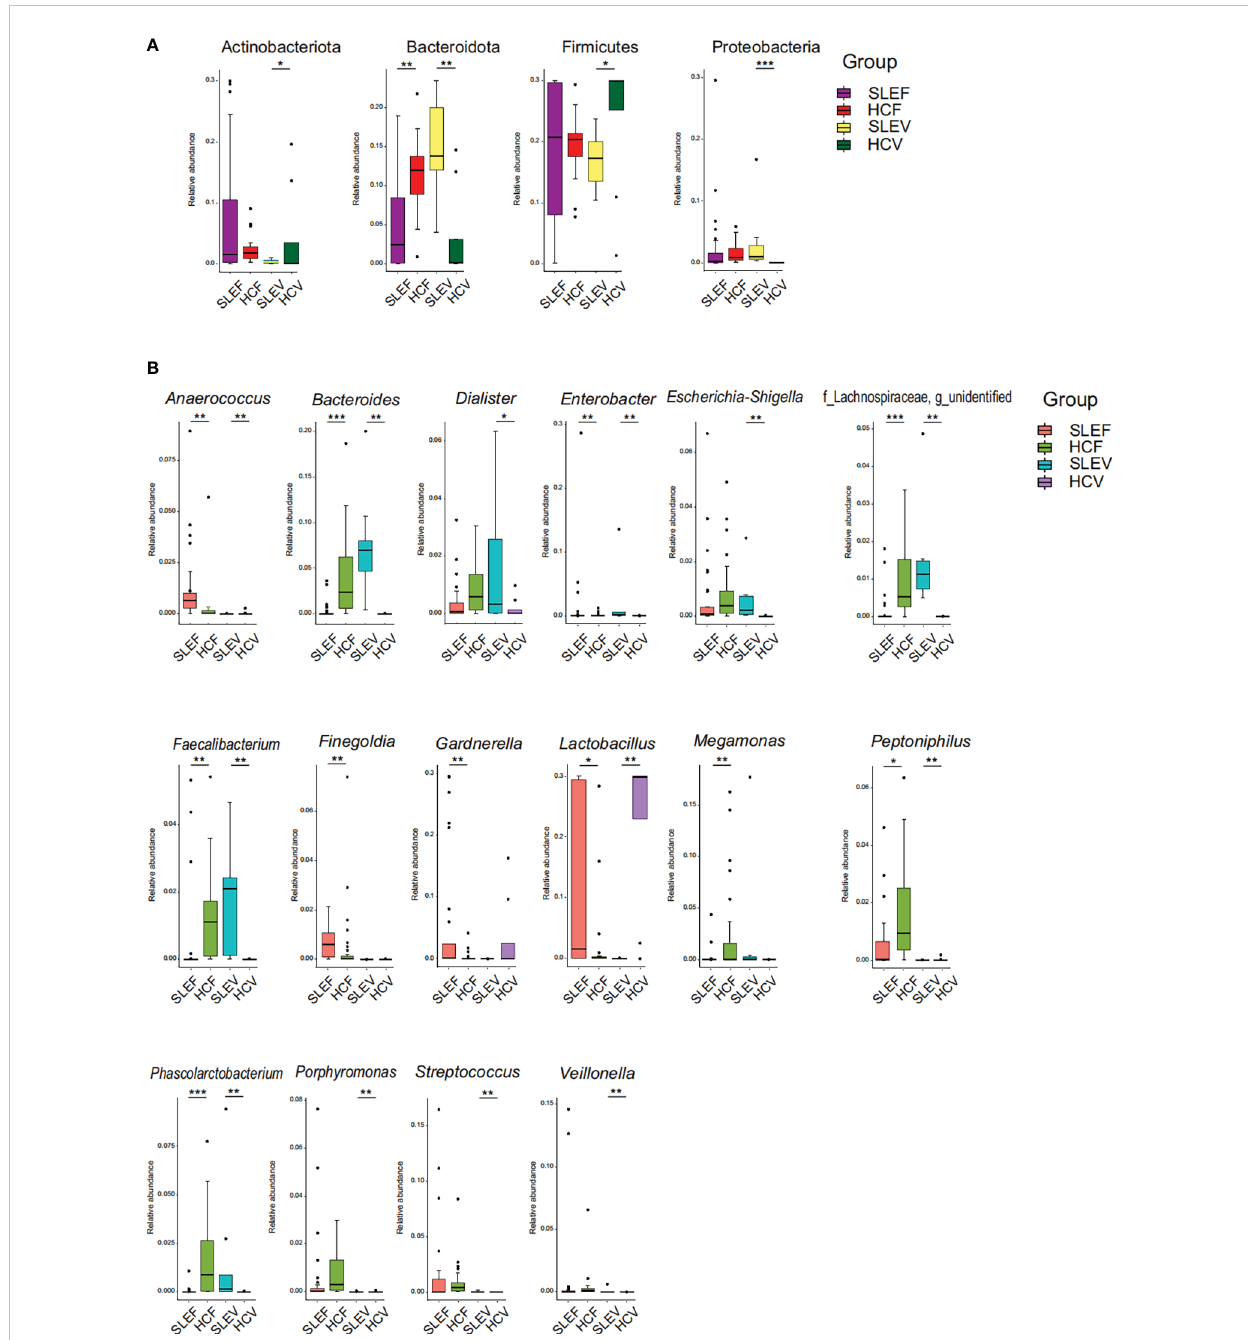
FIGURE 3 Bacterial taxons that were differentially abundant between SLE patients and controls. (A) Bacterial phyla signi fi cantly differed in SLE patients compared with those in controls. (B) Bacterial genera signi fi cantly differed in SLE patients compared with those in controls. The P-value was calculated using the Wilcoxon rank-sum test and adjusted using the Benjamini and Hochberg FDR. *FDR <0.05; **FDR <0.01; ***FDR